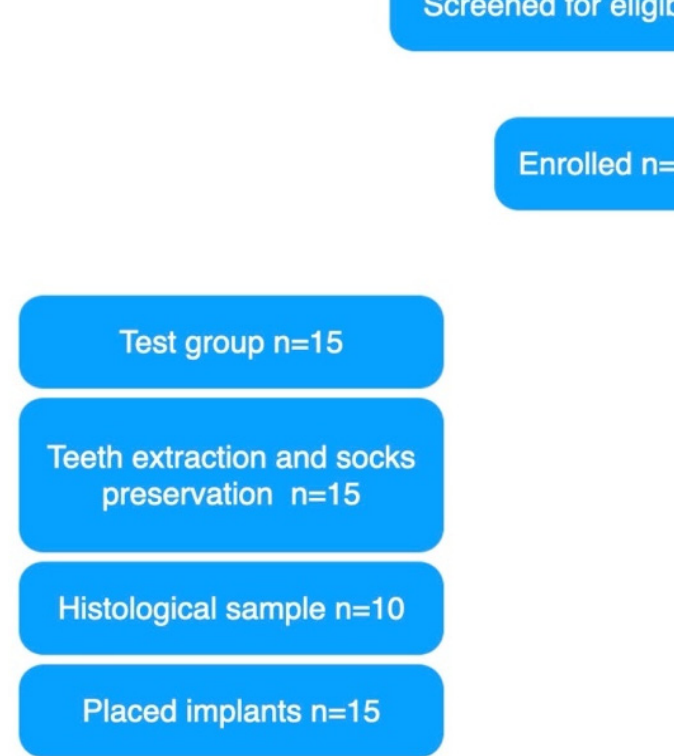
Figure 10. Participant flow diagram according to the CONSORT guidelines. Table 1. Patient and implant characteristics between groups.